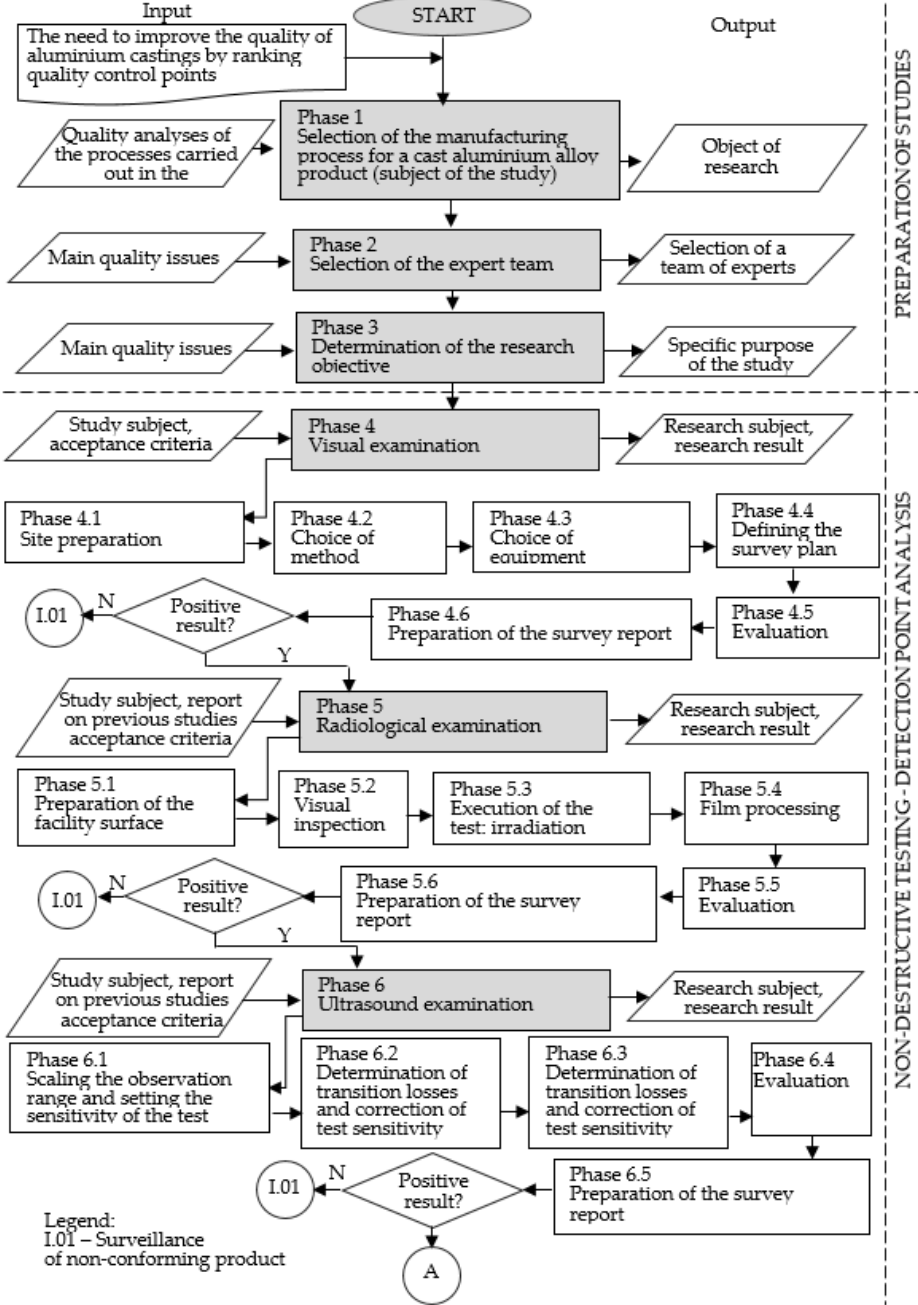
Figure 2. Rank model of casting non-conformity detection methods—part 1. Own development.